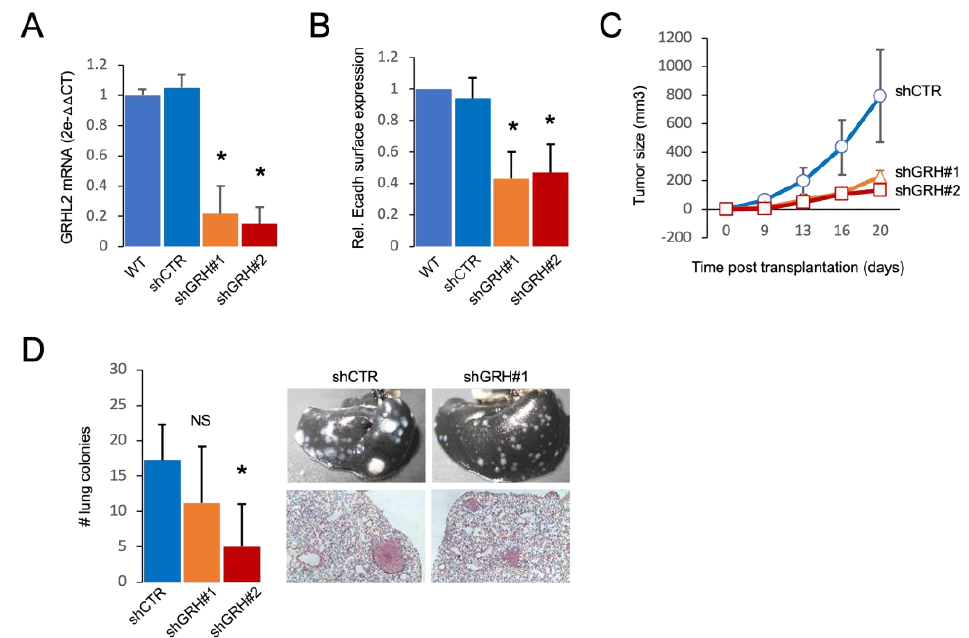
Figure 7. Effect of GRHL2 depletion in 4T1 basal A orthotopic transplantation model. ( A ) RT qPCR analysis of efficiency of GRHL2 depletion in 4T1 cells transduced with a control or 2 GRHL2 shRNA constructs. Mean and SEM of 3 biological replicates is shown. * p < 0.05. ( B ) FACS analysis of E cadherin surface expression in 4T1 variants described in A. Mean and SD of 3 experiments is determined and relative MFU (mean fluorescence units) compared to WT is shown. * p < 0.05. ( C ) Graph showing mean and SD for analysis of primary tumor growth after orthotopic transplantation of control and GRHL2 shRNA transduced 4T1 cells. At least 12 mice per condition in two experiments were analyzed. ( D ) Graph showing mean and SD for number of detected lung colonies for the experiment as in ( C ). NS, not significant; * p < 0.05. Right panel shows representative images of total lungs (top) and hematoxylin/eosin-stained lung sections derived from tumors of 4T1 cells transduced with a control or a GRHL2 shRNA construct.